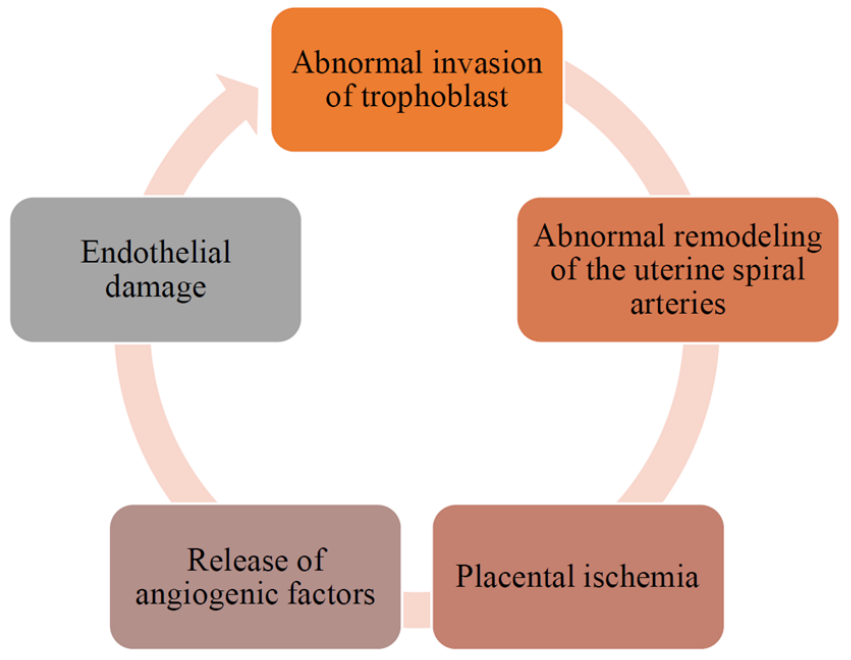
Figure 2. Pathogenesis of preeclampsia .